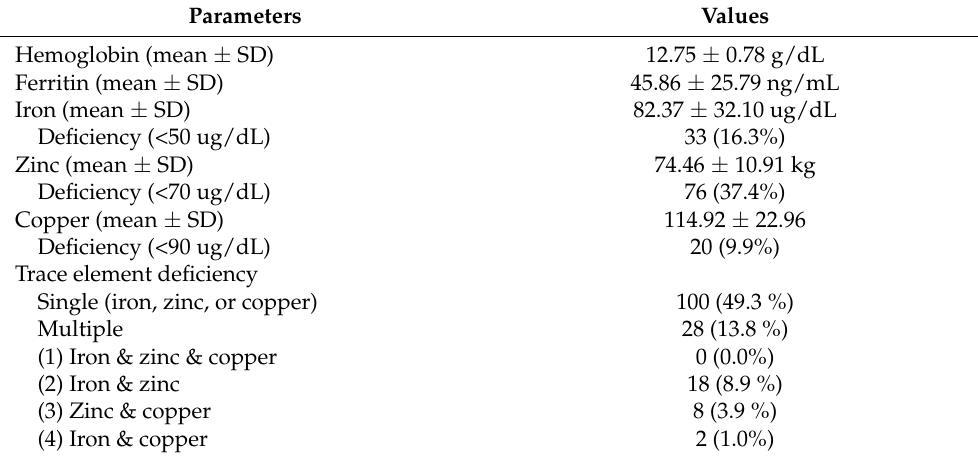
Table 2. Laboratory data and deficiency of trace elements of the